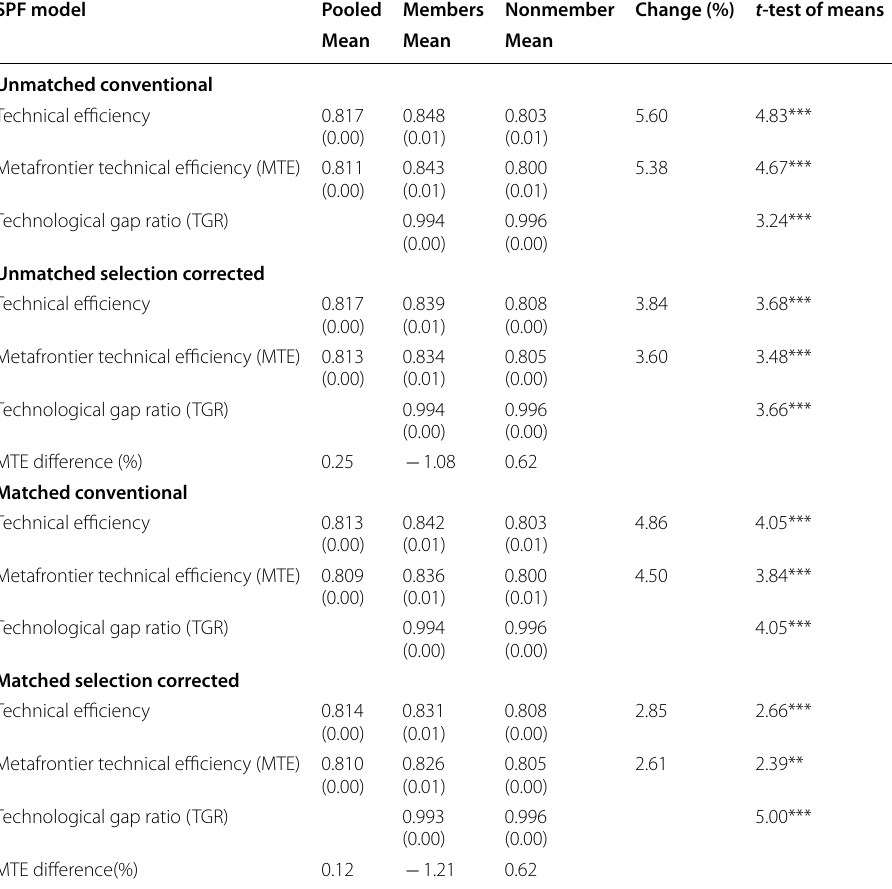
Table 6 Technical efficiency estimates across SPF